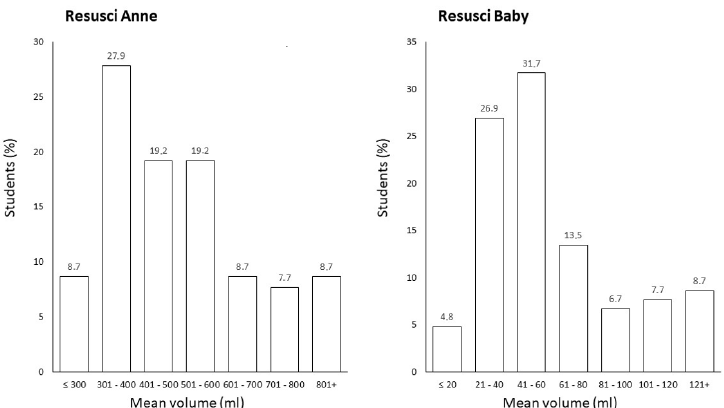
Figure 2. Mean volume of rescue breaths in all students ( n = 104).